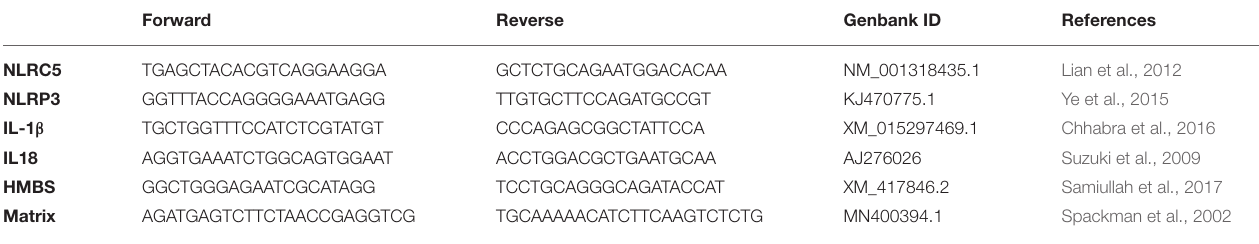
TABLE 1 | List of primers used in the